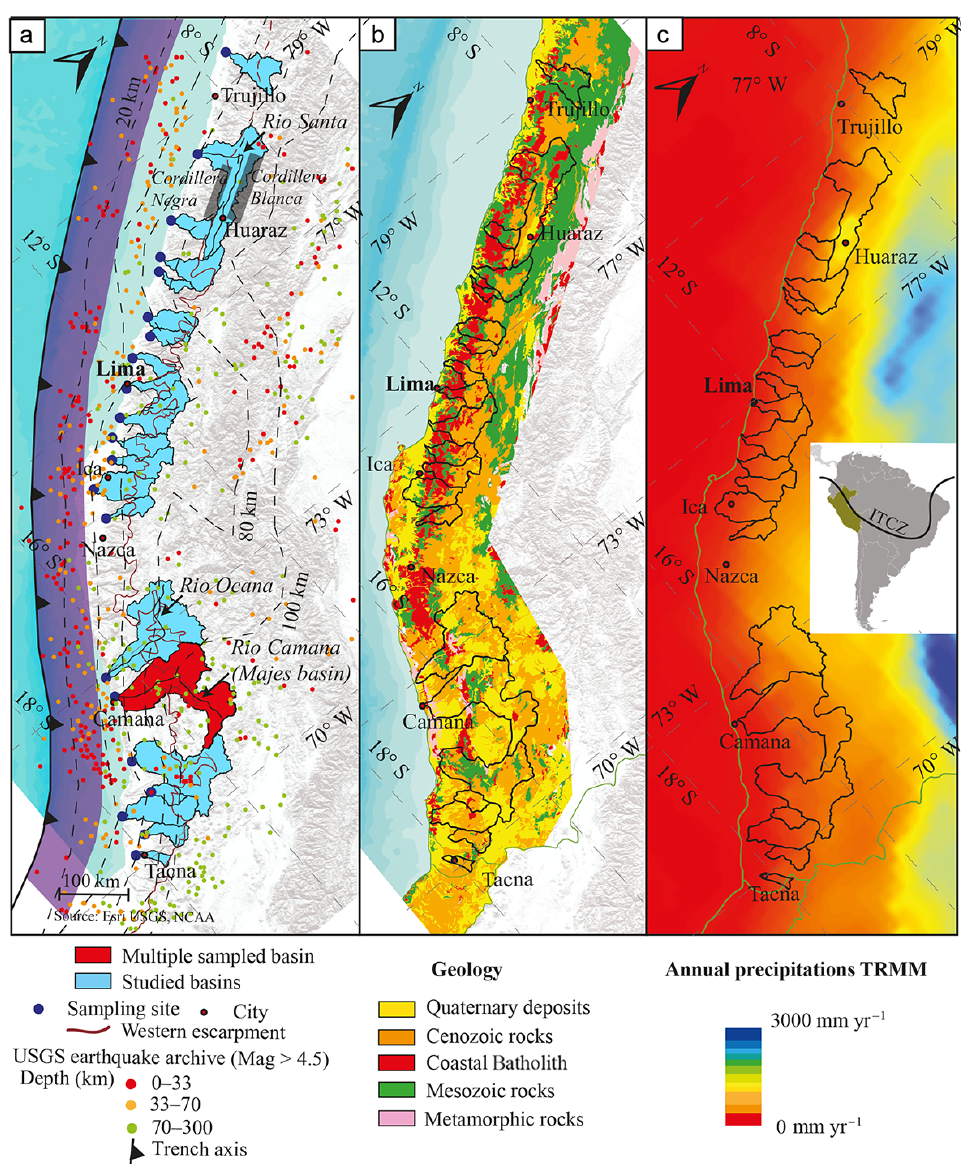
Figure 1. (a) Map of the studied basins showing the sampling sites and the western escarpment (western escarpment modified after Trauer- stein et al., 2013). The purple strip east of the trench axis corresponds to the swath over which the historical earthquake data, presented in Fig. 2. The map also illustrates the location of the buoyant Nazca ridge, depth of the slab as a dashed line, and patterns of earthquake occurrence. (b) Geological map of the western Peruvian Andes. (c) Map of the precipitation rates showing the spatial extent of the ITCZ, modified after Huffman et al.